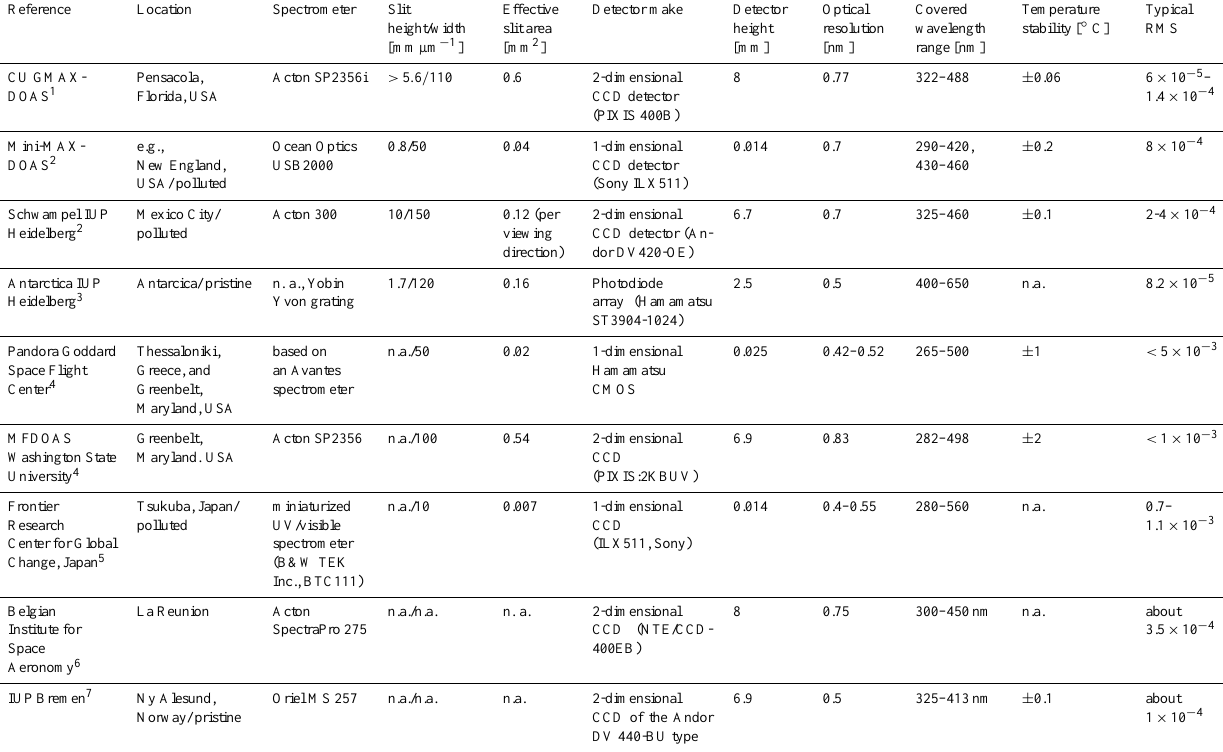
Table 1. Summary of performance capabilities and features of some of the currently reported MAX-DOAS instruments. The notation “n.a.” signifies information that was not available. The RMS values reported are from typical DOAS evaluation windows ranging from 15–40nm, with the exception of the Pandora Goddard Space Flight Center reference which uses a rather wide window of